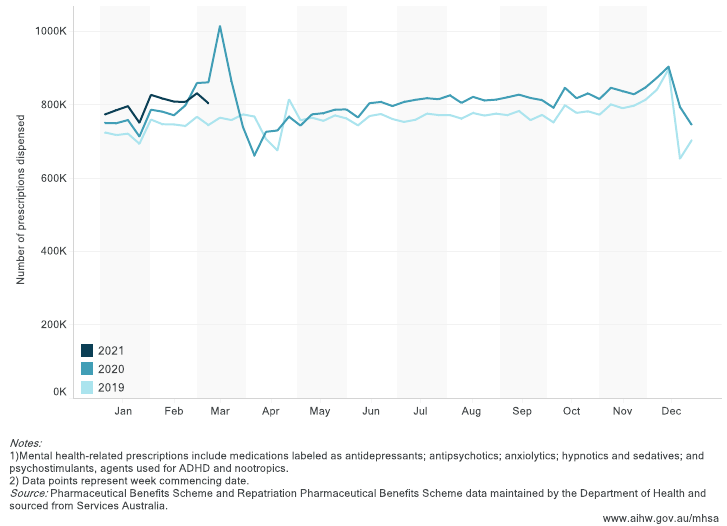
Figure 2. PBS mental health-related prescriptions dispensed (by week), January 2019–March 2021. (Website: https://www.aihw.gov.au/reports/mental-health-services/mental-health-services-in-aus-